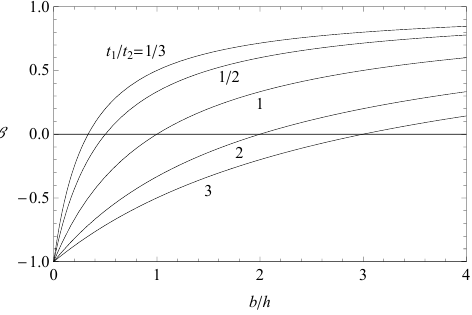
Figure 6. Warping ratio β = W t